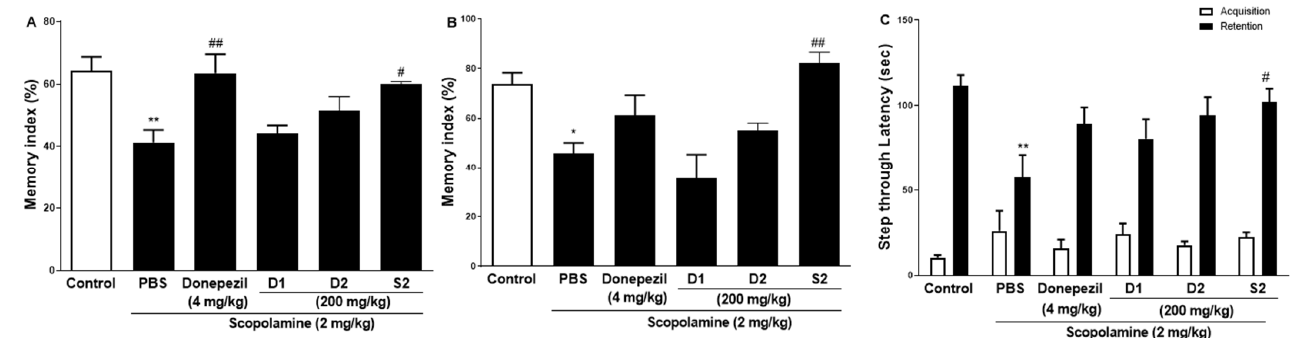
Figure 2. Effect of P. ginseng extracts on scopolamine-induced memory deficit in scopolamine-induced mouse. ( A ) The novel object recognition test (NORT), ( B ) Y-maze, and ( C ) passive avoidance test (PAT) were performed in mouse model. Values represent the mean ± SEM (n = 5). *: p < 0.05, **: p < 0.01, the significant difference compared with the control and compared with Scopolamine